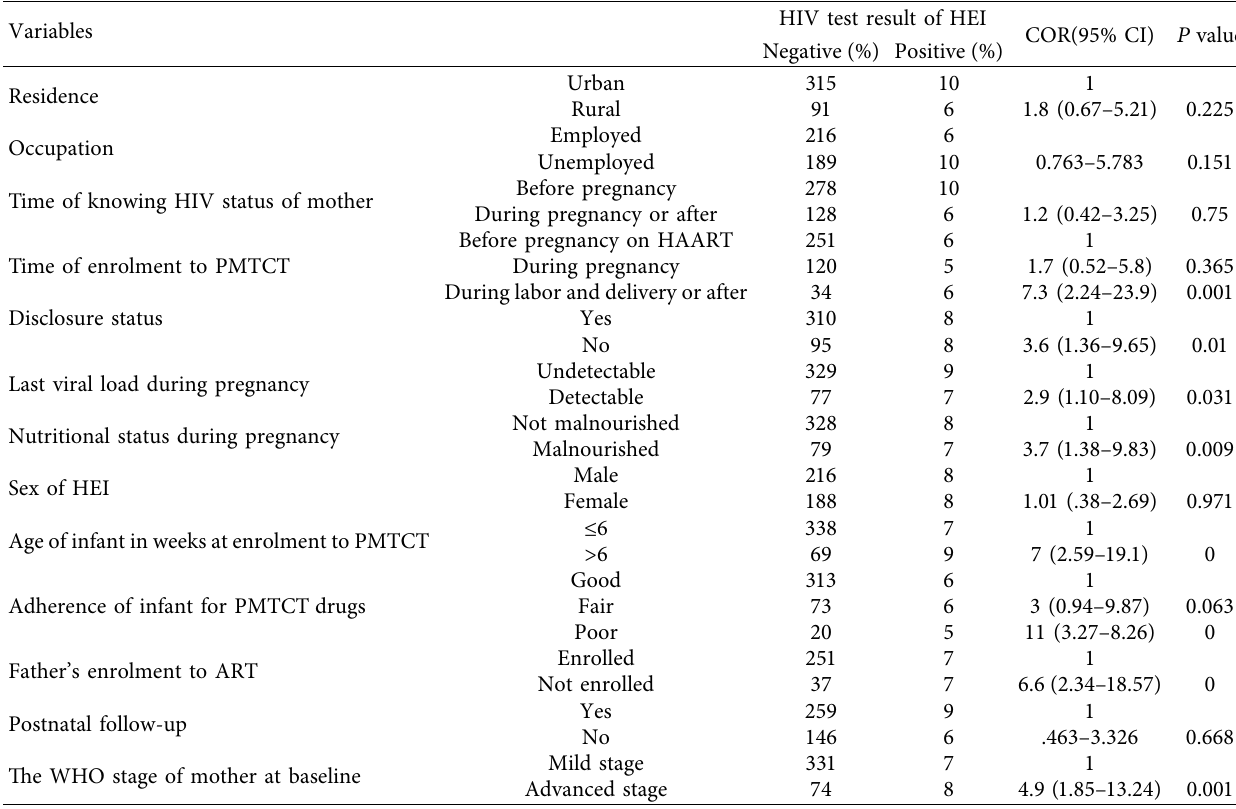
Table 3: Bivariate analysis of predictors of MTCTof HIV in public general hospitals of West Guji Zone, Oromia, Ethiopia, 2020 ( n � 422). Variables